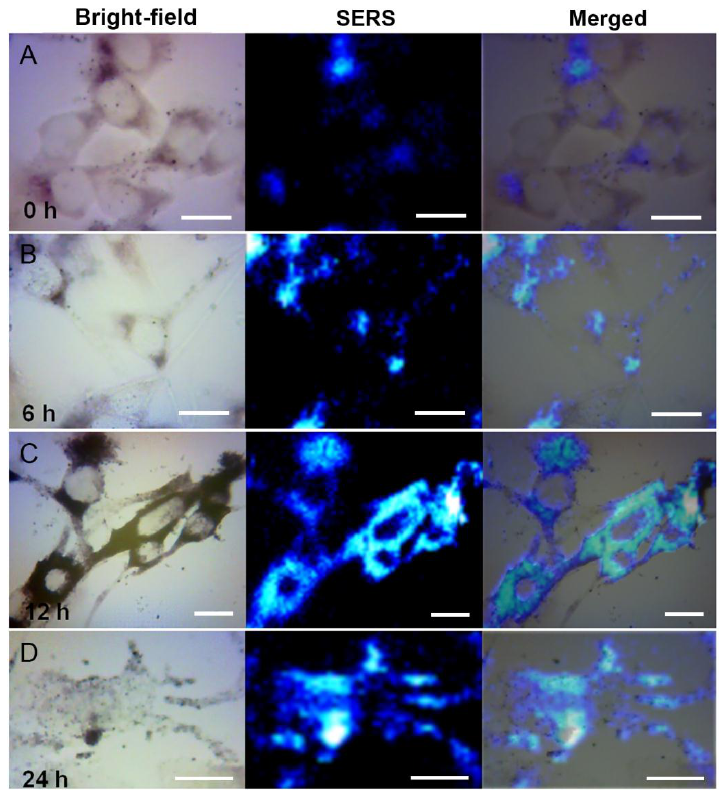
Figure 5. Surface-enhanced Raman scattering (SERS) monitoring of melanogenes is in 3-isobutyl-1-methylxanthine (IBMX)-treated B16-F10 cells. SERS images are acquired after IBMX treatment at ( A ) 0 h; ( B ) 6 h; ( C )12 h; and ( D ) 24 h. Scale bar = 20 μm.